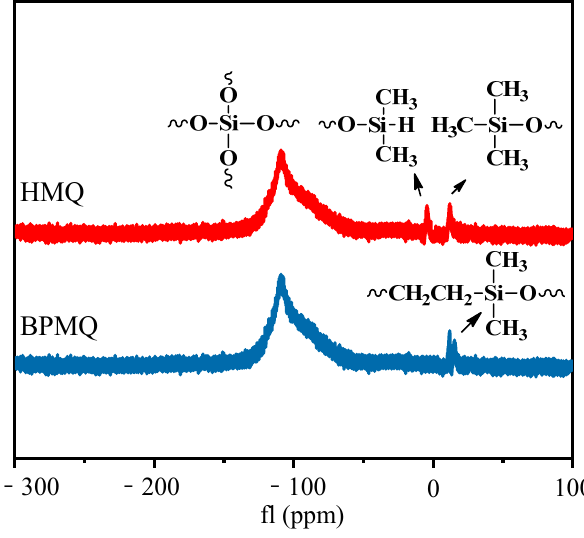
Figure 4. 29 Si NMR spectra of HMQ and BPMQ.